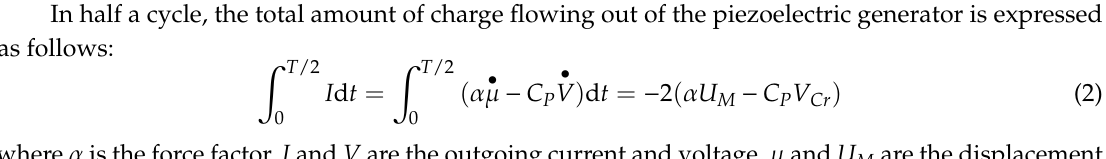
Figure 3. Waveforms in the bridge rectifier interface circuit.